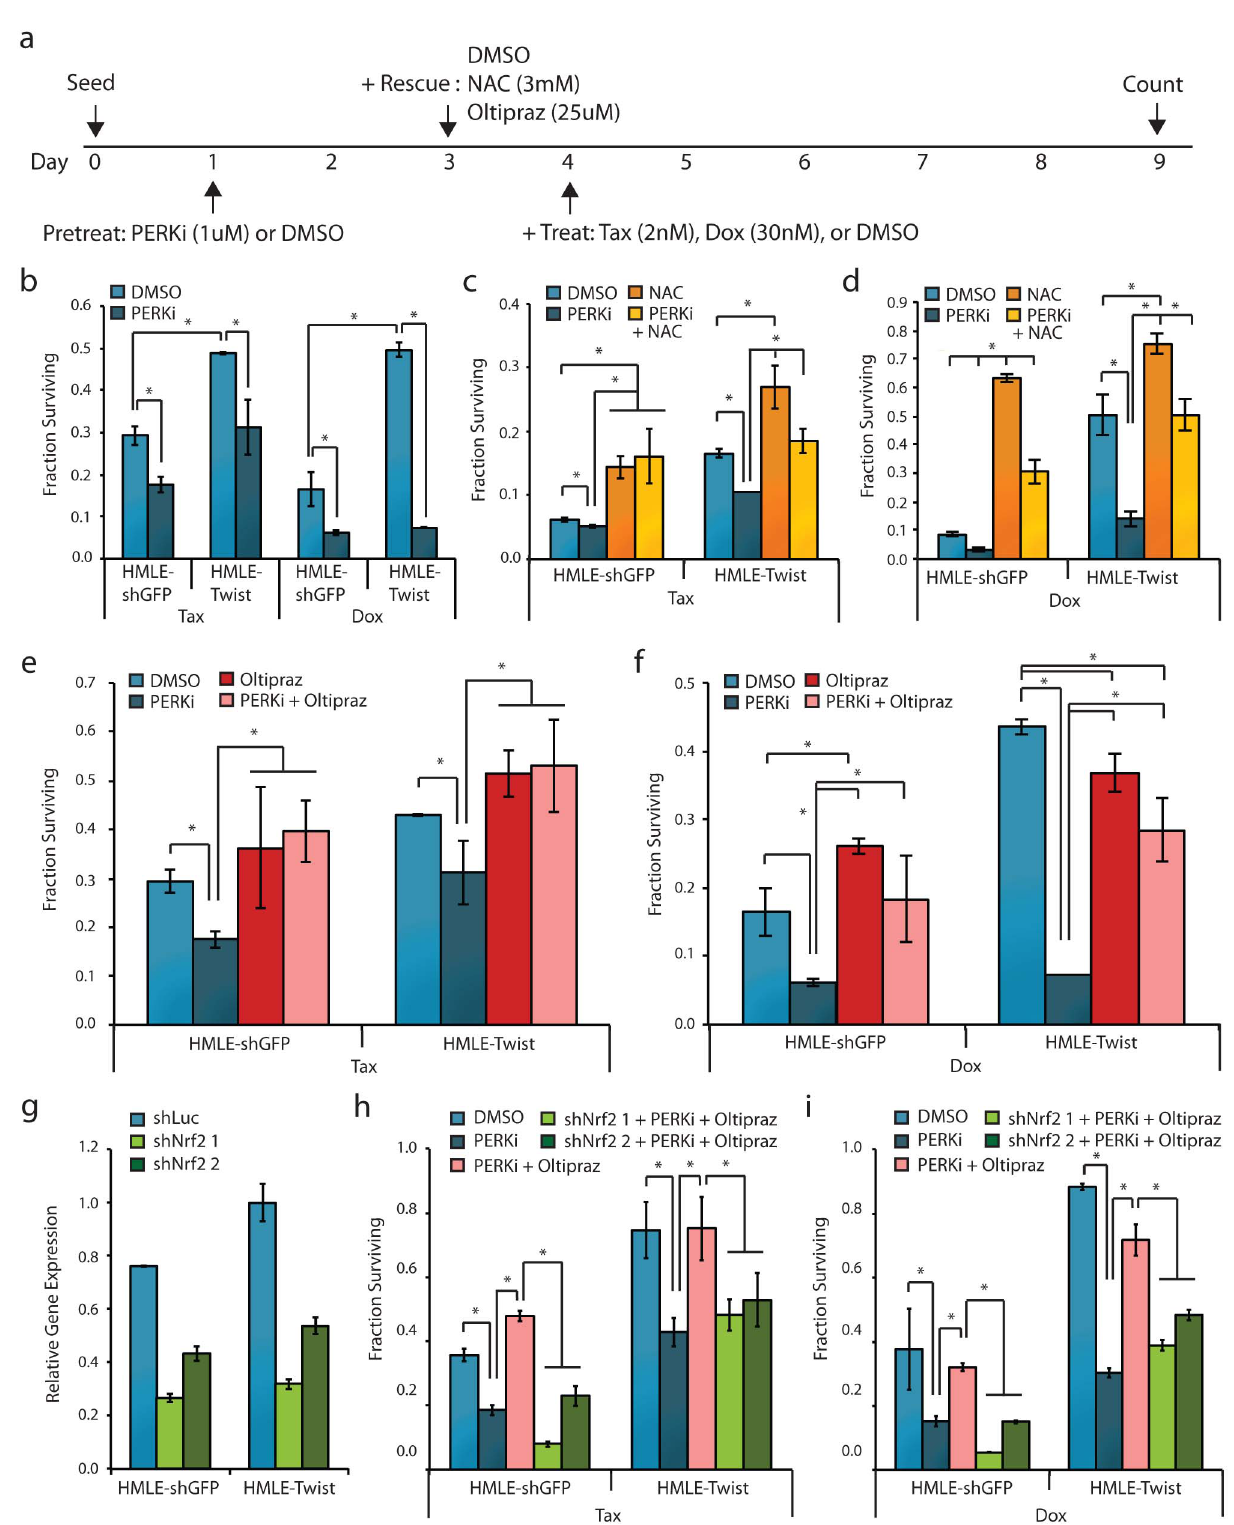
Figure 4. Inhibition of PERK-Nrf2 signaling sensitizes de-differentiated cells to chemotherapy. (a) Schematic of treatment timing and dosage for cell survival experiments described in (b–f). (b) Fraction of cells surviving 2 nM Tax or 30 nM Dox following pretreatment with 1 m M PERKi or DMSO, normalized to individual vehicle-treated controls. (c and d) Fraction of cells surviving 30 nM Dox (c) or 2 nM Tax (d) following pretreatment with 1 m M PERKi or DMSO and rescue with 3 mM NAC, normalized to individual vehicle-treated controls. (e and f) Fraction of cells surviving 30 nM Dox (e) or 2 nM Tax (f) following pretreatment with 1 m M PERKi or DMSO and rescue with 25 m M Oltipraz, normalized to individual vehicle-treated